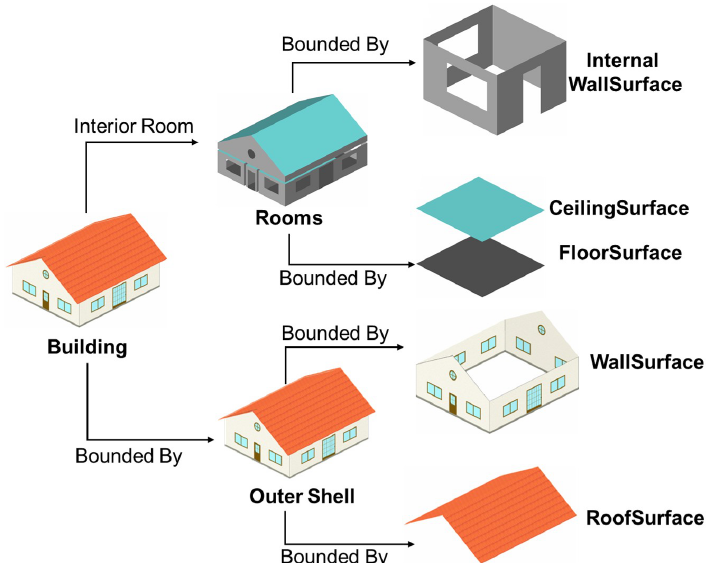
Figure 1. Overview of a building represented in CityGML format. Image adapted from: